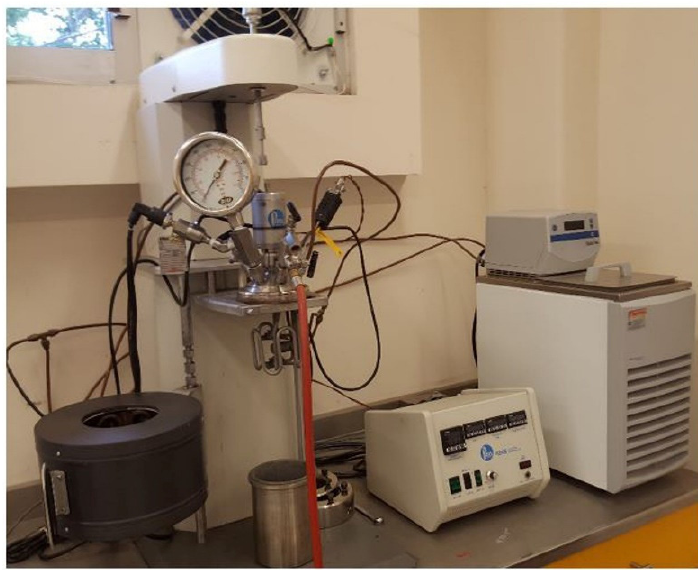
Figure 1. Experimental setup for simultaneous pressure leaching and oxidation. Table 1. Process variables and parameters for simultaneous pressure leaching and oxidation.